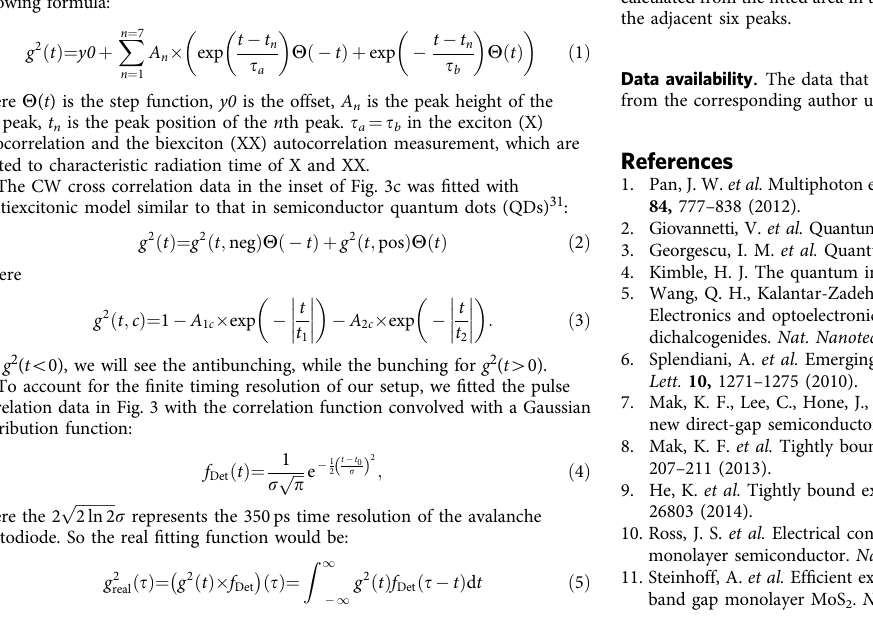
grating with the spectral resolution B 70 m eV. Photon autocorrelation measure- ments were performed after collecting the signal into a multimode fibre beam splitter, where the counts were recorded by two single-photon avalanche photo- diodes. The correlation function for the pulse experiments was described in the